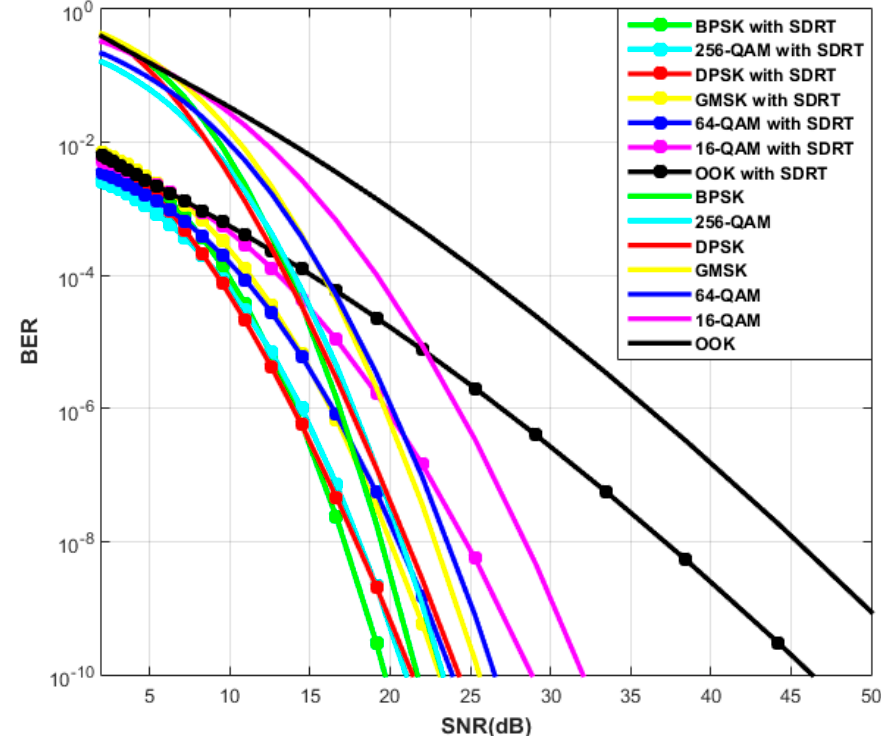
Figure 8. BER performance of different modulation formats with SDRT and without SDRT in a moderate turbulence channel.